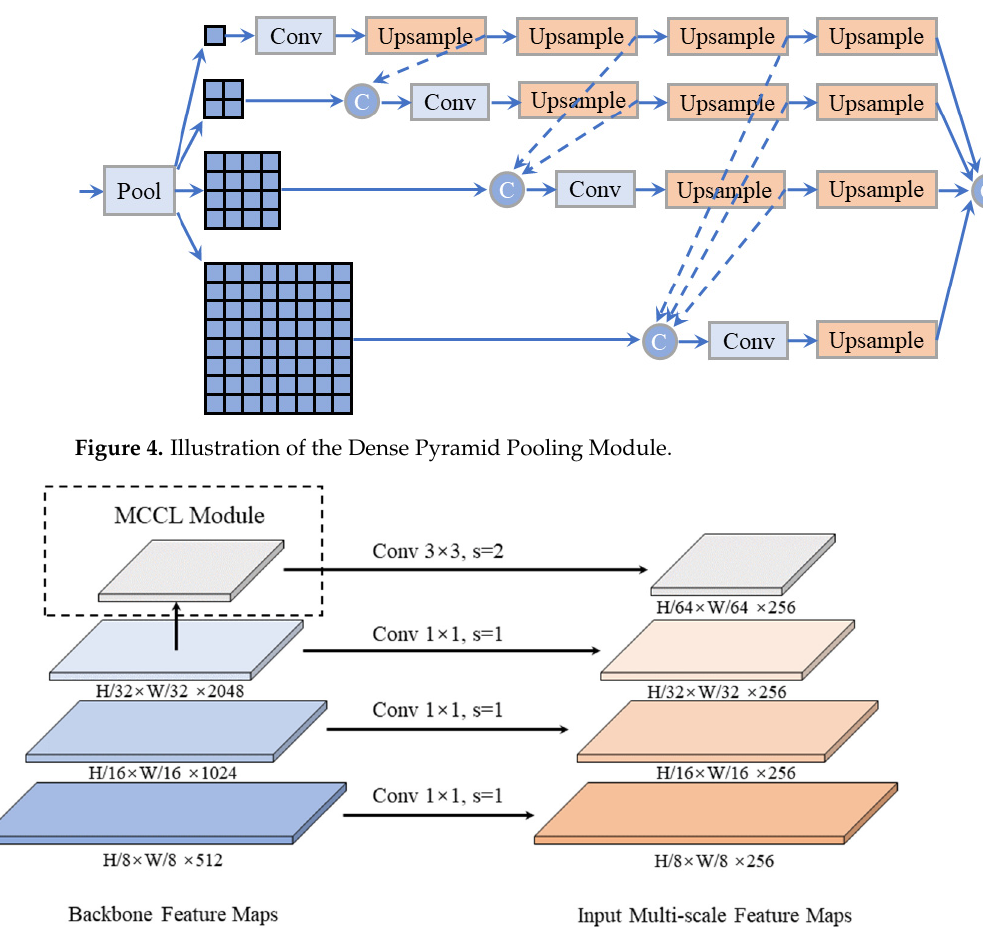
Figure 5. Location of the MCCL module in deformable DETR. MCCL module processes the lowest- resolution feature maps on C 5 stage.